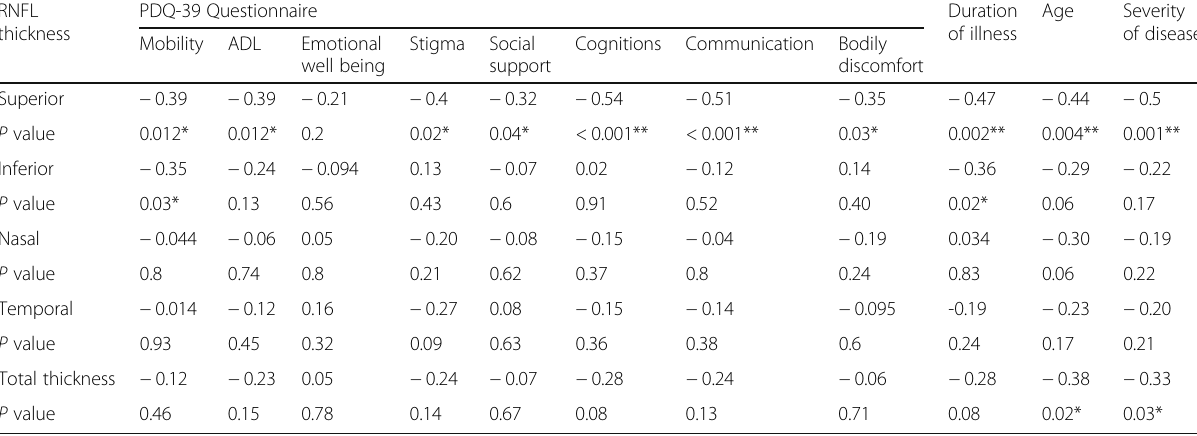
Age Severity of illness of disease